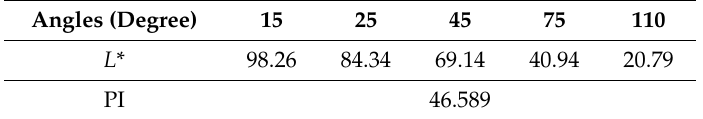
Table 10. Pearlescent characterization results of the M X2C2 sample for 7 h sonication time.